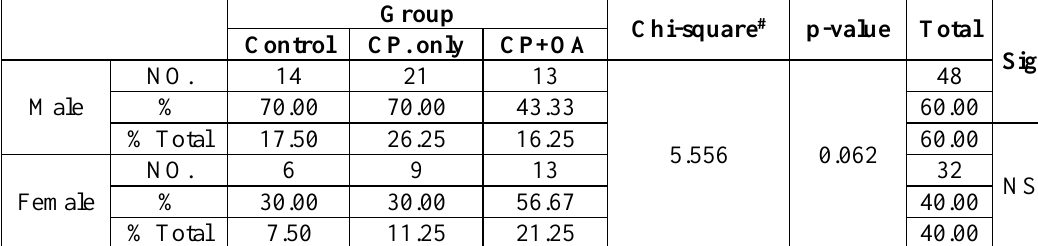
Table 1: Gender distribution among study groups.